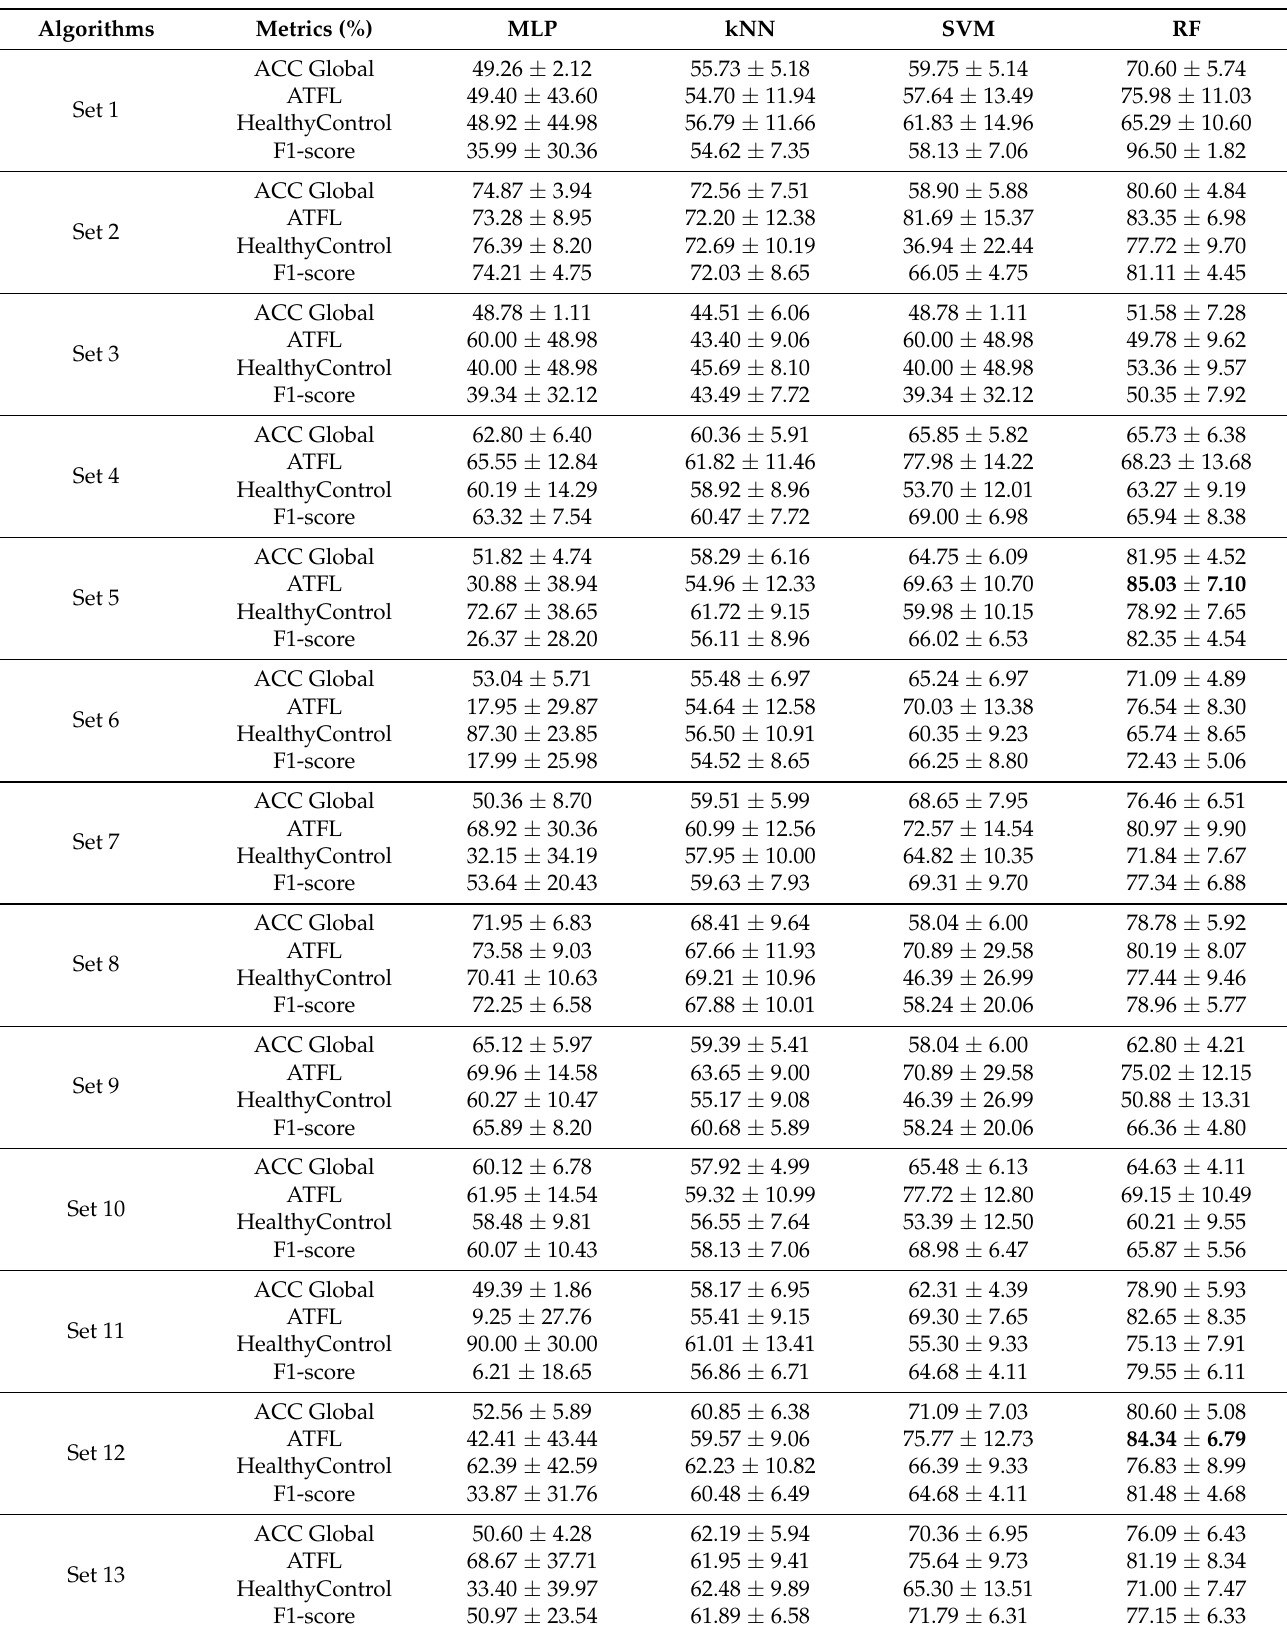
Table 5. Detailed results of the evaluation